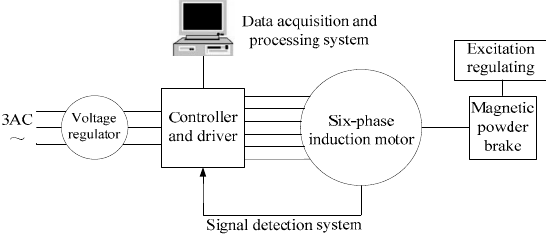
Figure 13. Block diagram of the experimental platform.